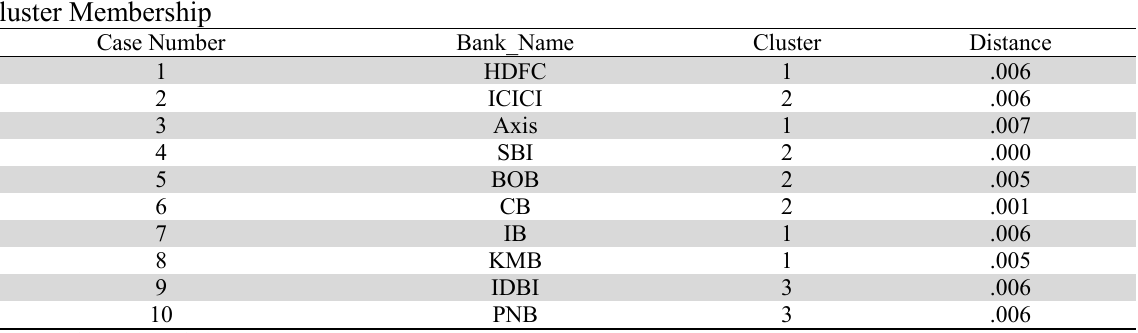
Cluster Membership Case Number